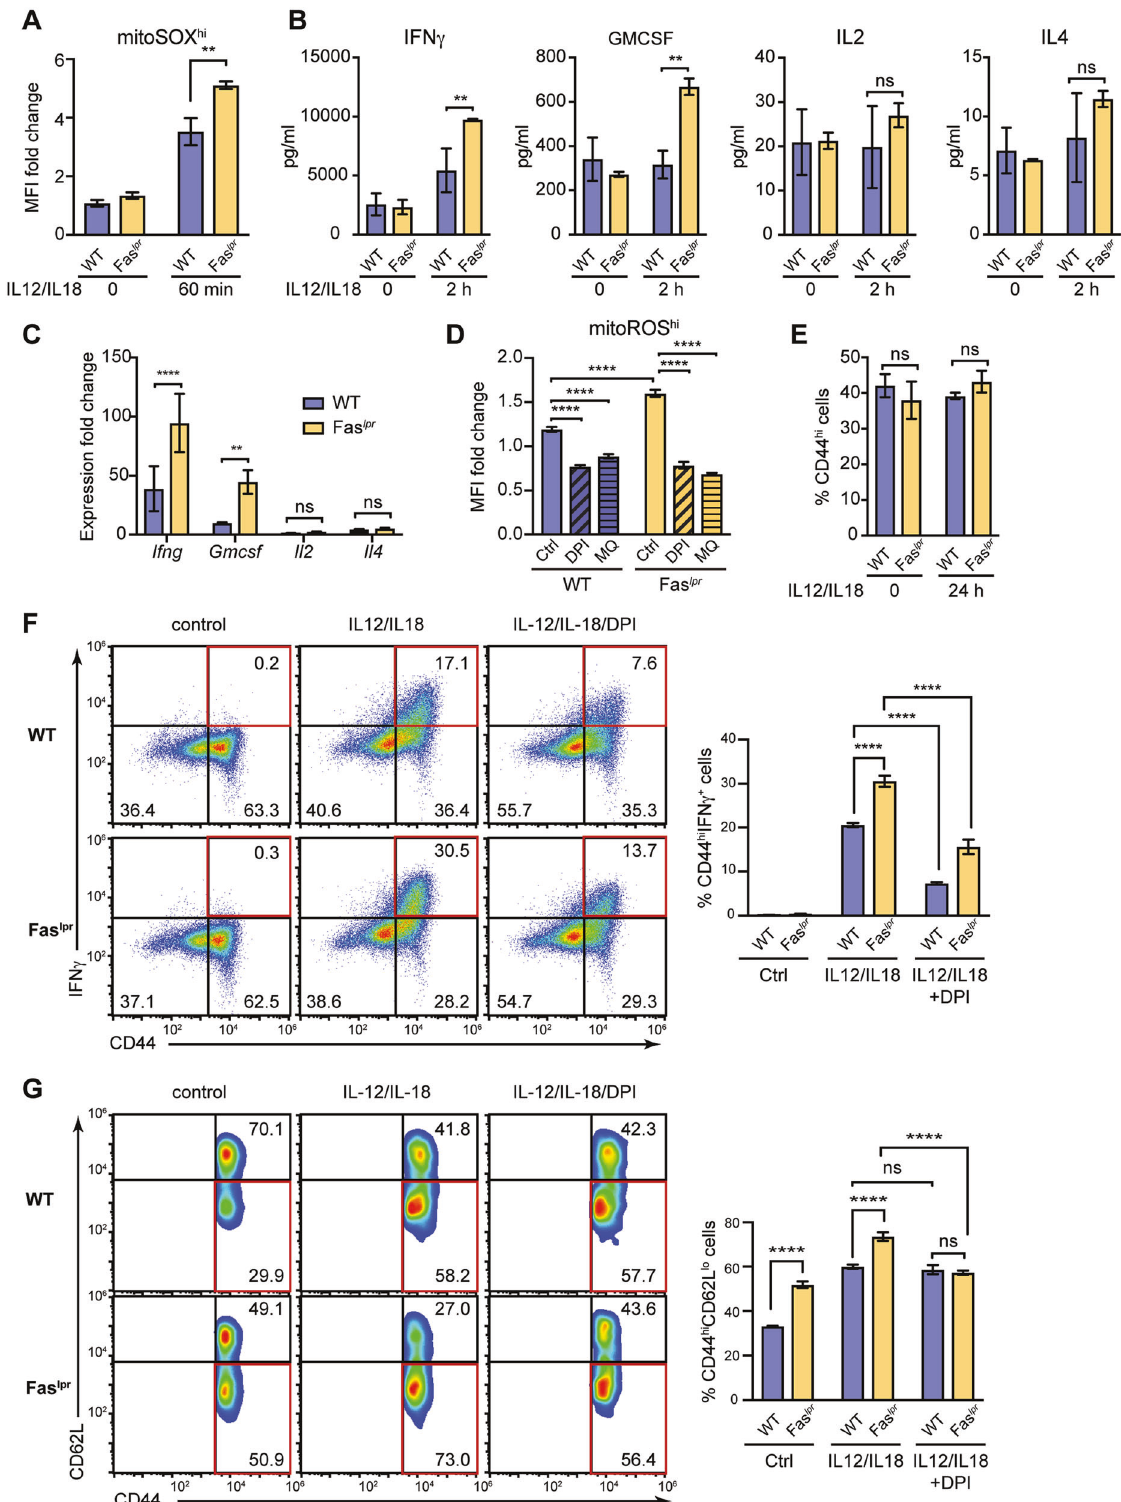
Fas/FasL interaction controls mROS and IFN- γ production after IL-12/IL-18 challenge The mechanism underlying elevated mROS and IFN- γ production in Fas-de fi cient memory-like CD4 T cells involved